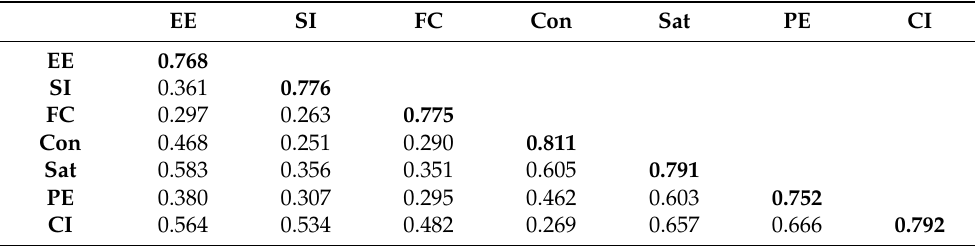
Table 3. Matrix of correlation constructs and discriminant validity.